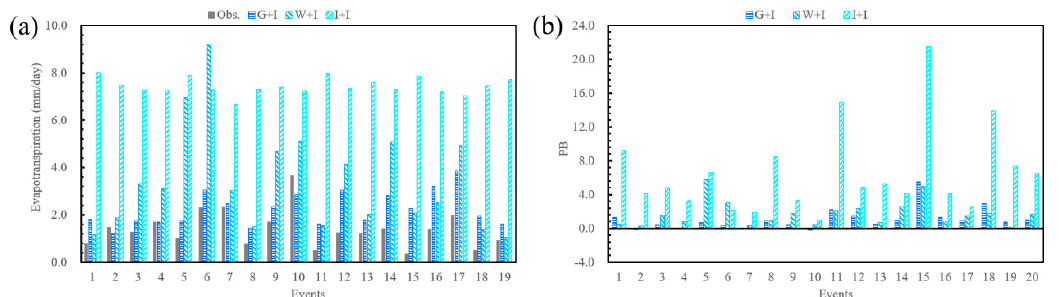
Figure 7. Daily mean evapotranspiration (ET)-volume ( a ) of observation, G + I, W + I and I + I, and the PB ( b ) of last three scenarios at the grid containing HYK station for each event. The last columns in ( b ) represents the PB mean-values of 19